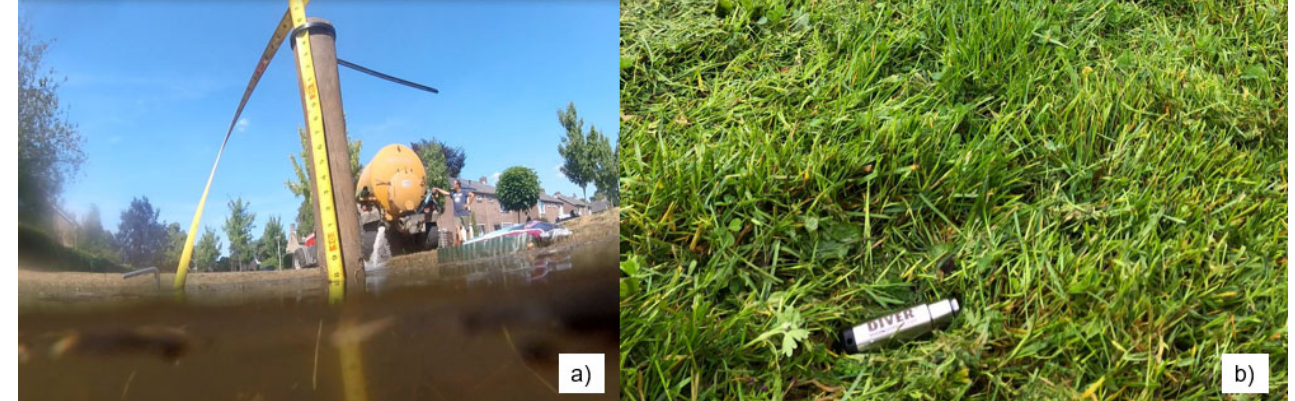
Figure 7. The methods for monitoring the water height in the swales during the infiltration tests were ( a ) hand measurements on a measuring tape and underwater video camera, continuous time-lapse photography ( b ) and pressure transducer loggers.